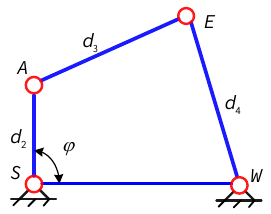
Figure 2. Feature of the self-motion.